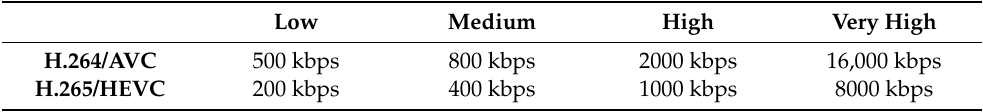
Table 3. Compression Bitrate values used for each